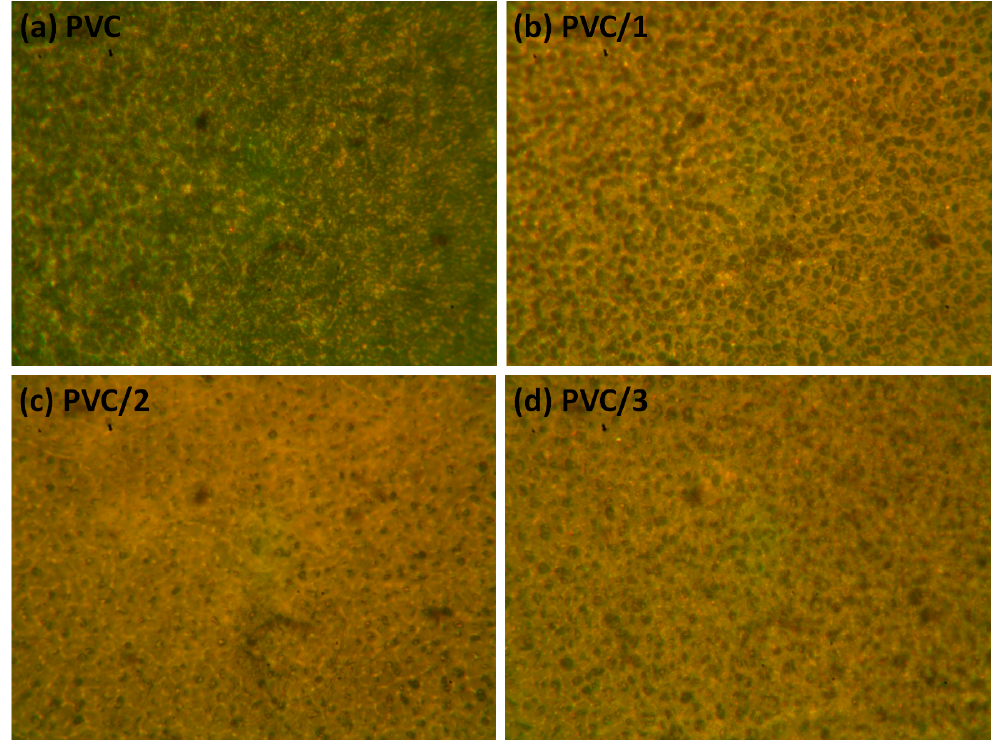
Figure 11. Surface morphologies (400× magnification) of ( a ) the blank PVC film and the PVC films containing ( b ) complex 1 , ( c ) complex 2 , and ( d ) complex 3 after irradiation for 300 h.